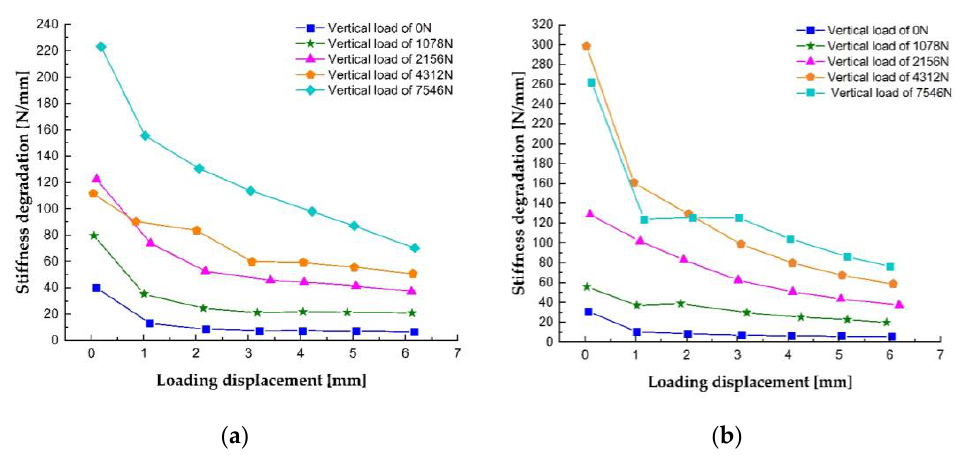
Figure 11. Stiffness degradation of specimen: ( a ) Frontal direction and ( b ) Lateral direction.